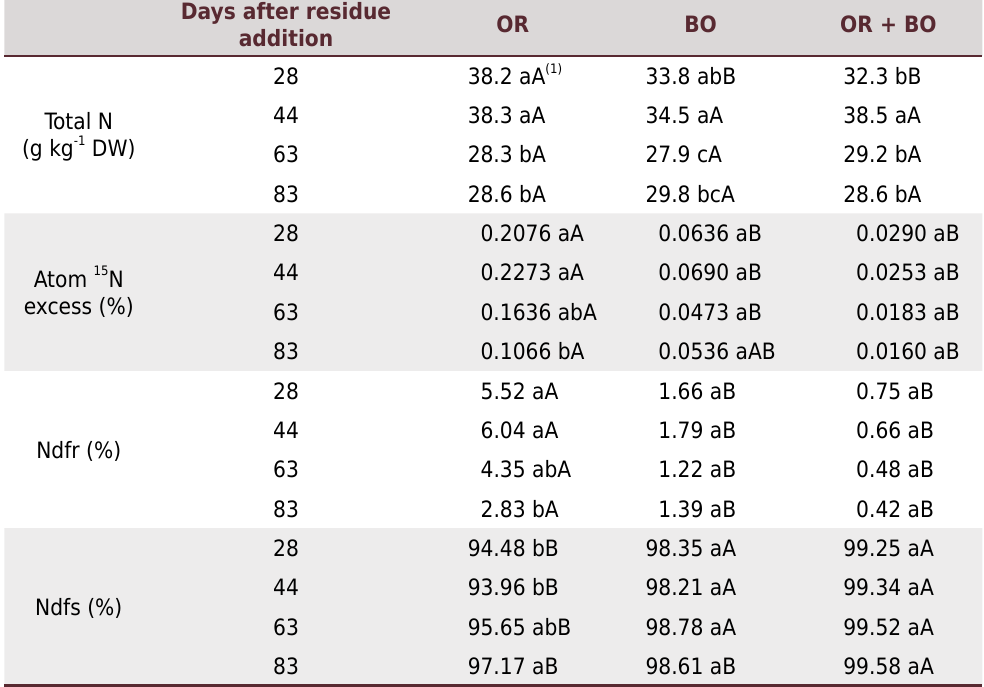
Table 3. Total N, atom 15 N excess, N derived from residues (Ndfr), and N derived from other sources (Ndfs) in the youngest fully expanded onion leaves collected at 28, 44, 63, and 83 days after addition of oilseed radish (OR), black oat (BO), and intercropped oilseed radish + black oat (OR + BO) residues Days after residue